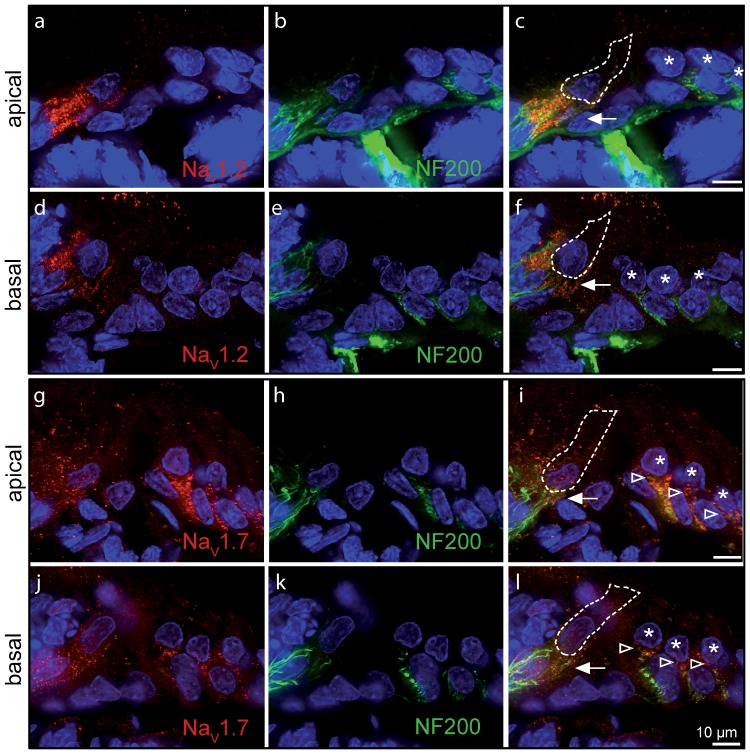
NaV1.2 and NaV1.7 are absent from immature IHCs. Apical (a–c, g–i) and basal (d–f, j–l) turns of immature (P5) rat cochlea. Antibodies to NaV 1.2 and NaV 1.7 (red) mainly labeled nerve fibres below IHCs (arrow) and OHCs (arrowheads), and colocalized with anti-neurofilament antibody (NF200, green). Scale bars represent 10 µm. Cell nuclei are marked by DAPI (blue).